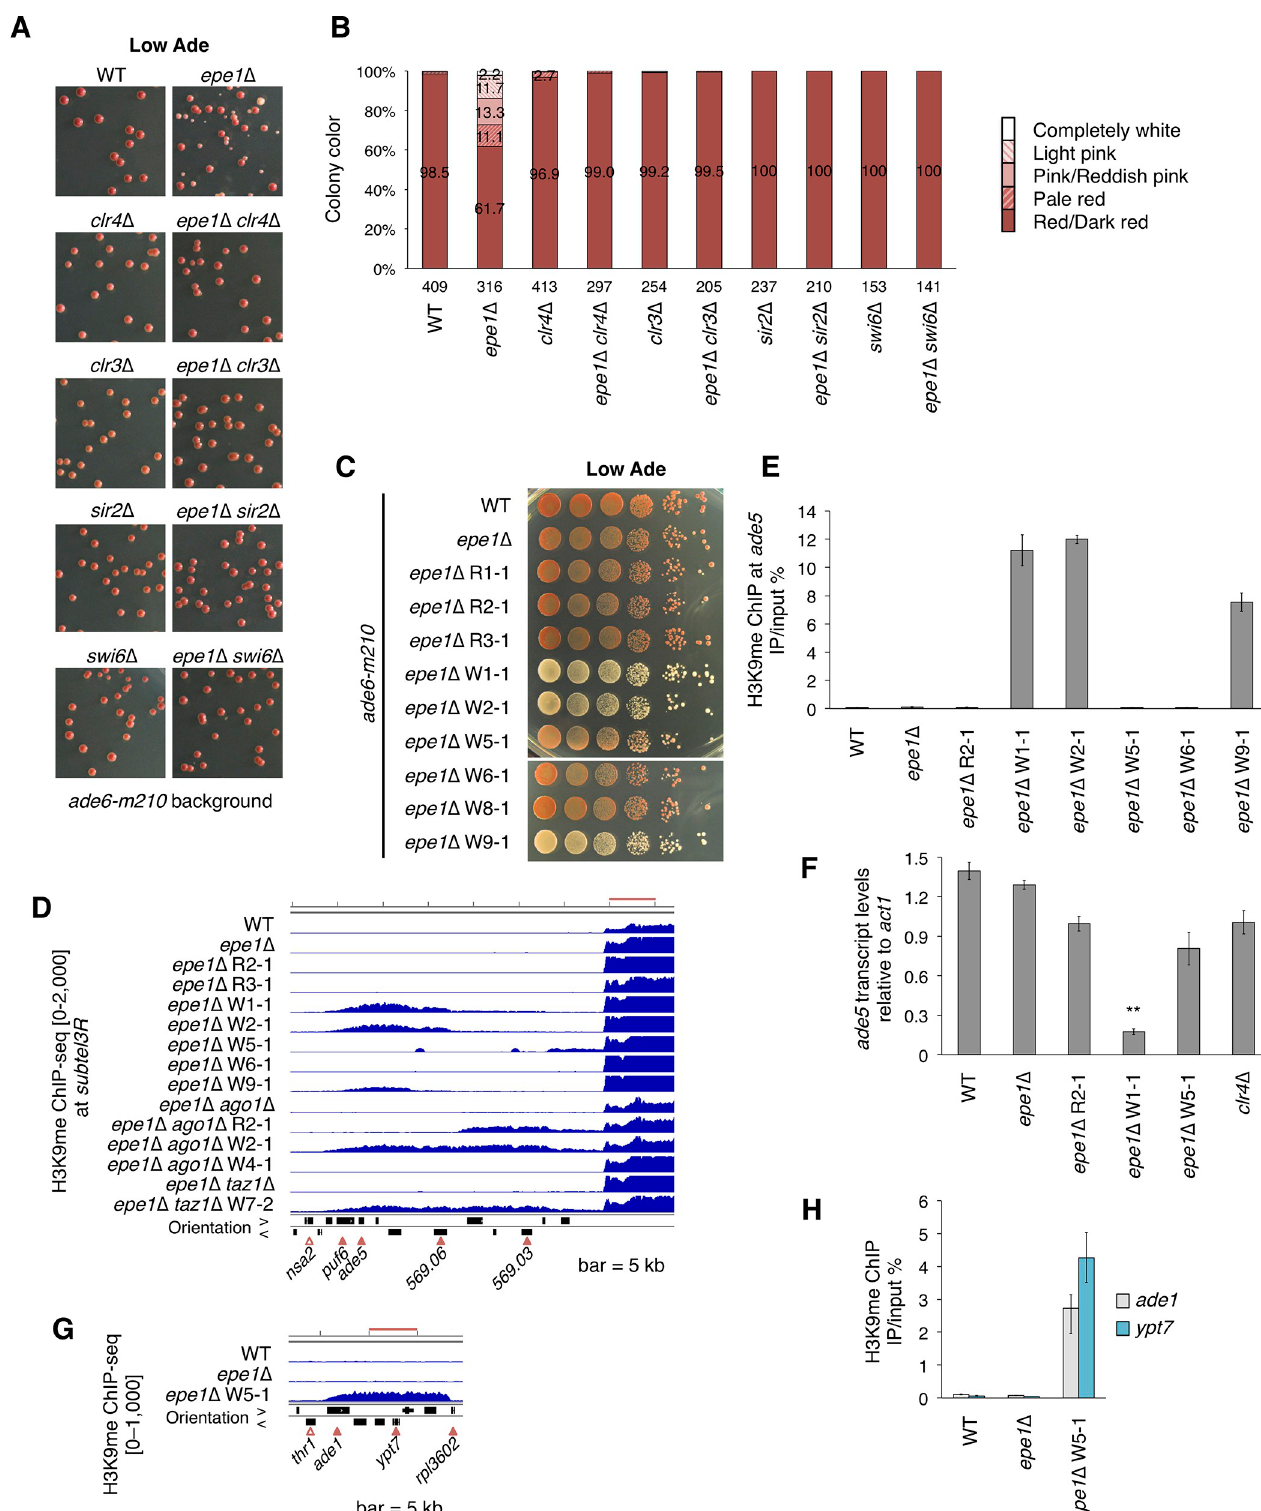
Fig 2. The red-white variegation phenotype is linked to ectopic heterochromatin formation. (A) Comparison of colony color among double deletion mutants on adenine-limited medium. These strains had no ade6 + marker. Endogenous ade6 is disrupted by a loss-of-function mutation ( ade6-m210 ) [29].